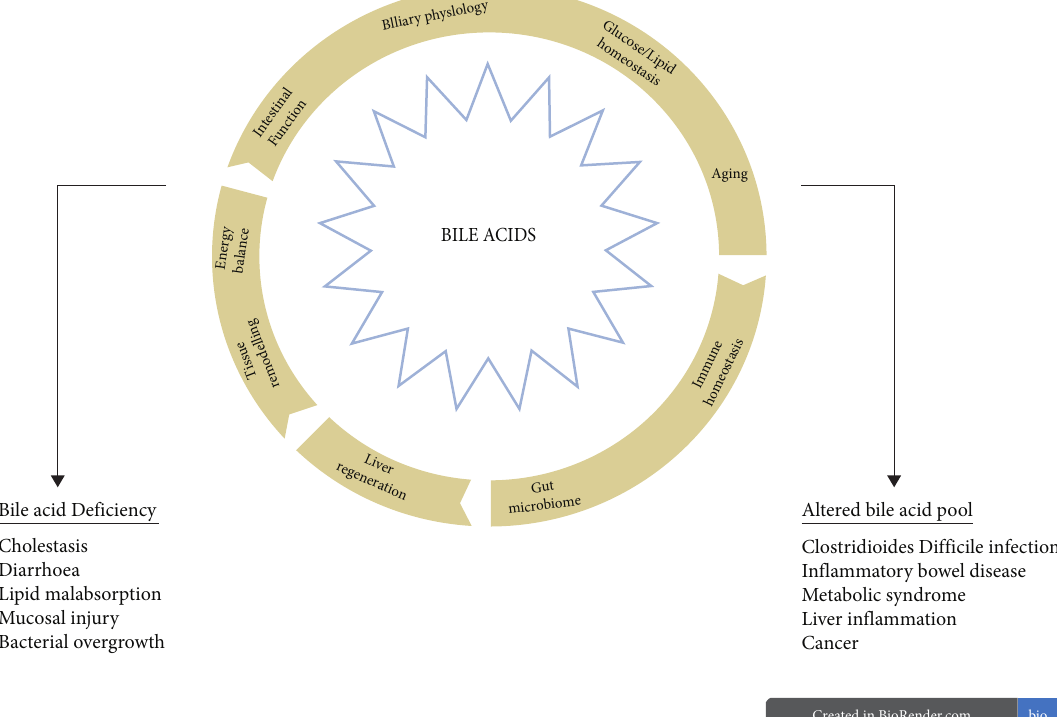
Figure 1: The multifunctional roles of bile acids and the symptoms and diseases they can contribute to when the BA pool is deficient or altered. Image modified from Perino et al.